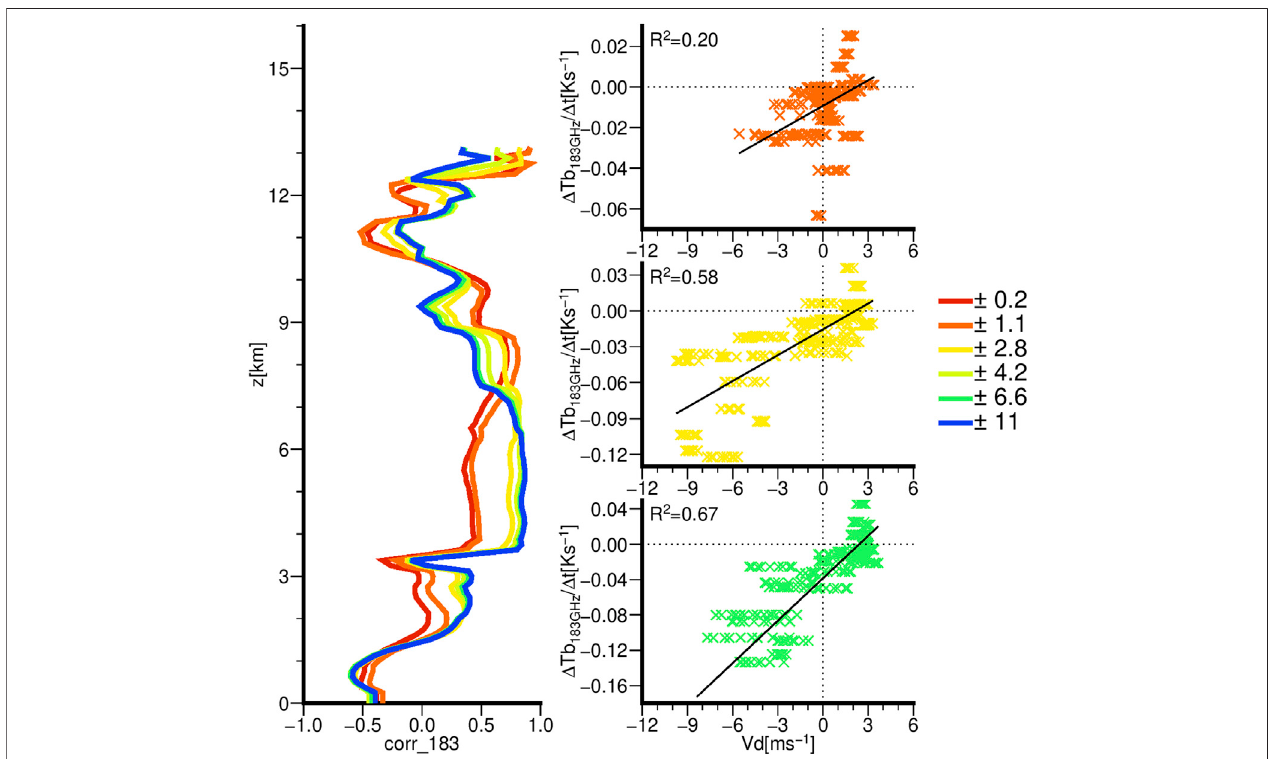
FIGURE 9 | Correlation coef fi cient computed at each altitude between radar Doppler velocity and temporal derivatives of the six SAPHIR bands sampling the 183 GHz water vapor absorbing band for convective pro fi les ( fi rst vertical panel). Brightness temperature temporal derivatives (dTb/dt in K/s) as a function of Doppler velocity V d (in m/s) for convective pro fi les in 1 km-depth altitude layer centered on the peaks of the weighting functions (second vertical panel) for SAPHIR channels C2, C3 and C5. The black lines are linear regressions and the associated R 2 are provided.